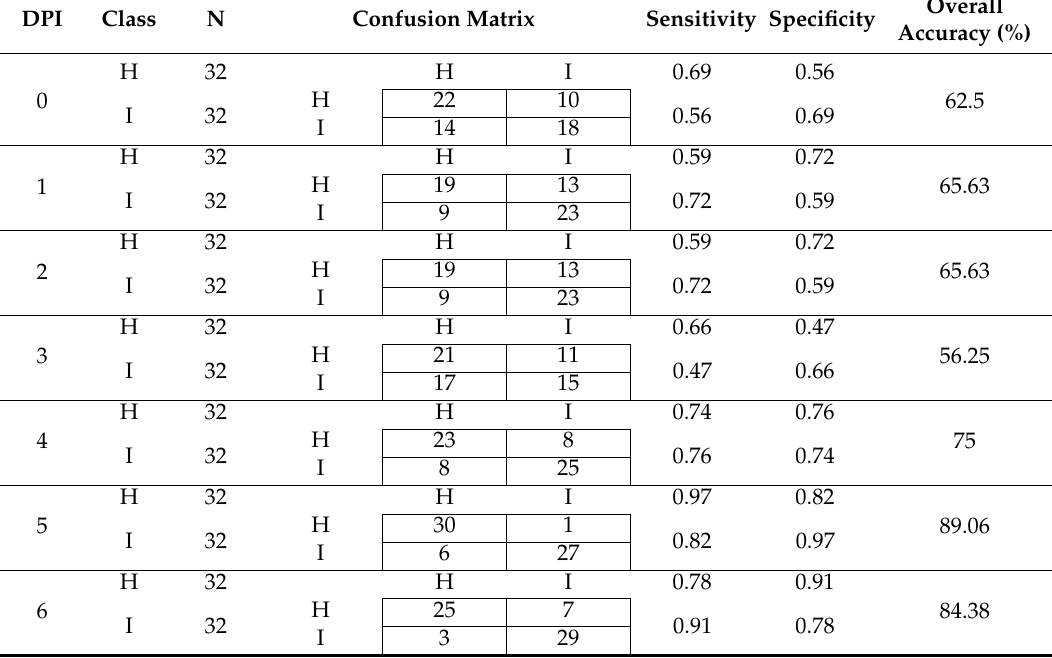
Table 8. Confusion matrix and related classification statistics when a Cubic Support Vector Machine classifier is applied to the reflectance at 668 1 , 705 2 , 717 3 and 740 4 nm to classify 32 healthy and 32 infected spectral observations acquired at canopy level as a function of the number of days post-inoculation